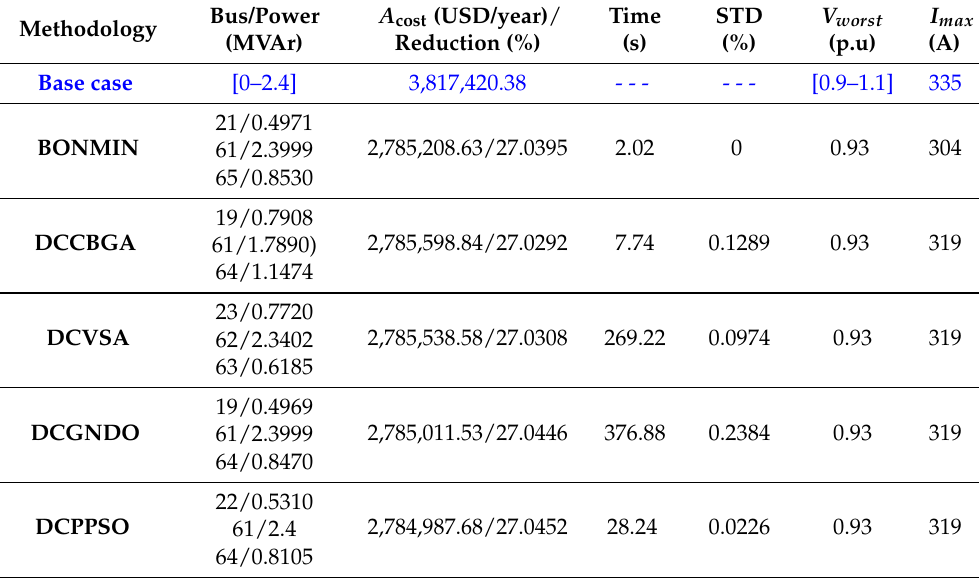
Table 4. Simulation results obtained by solution methods in the 69-bus test system.